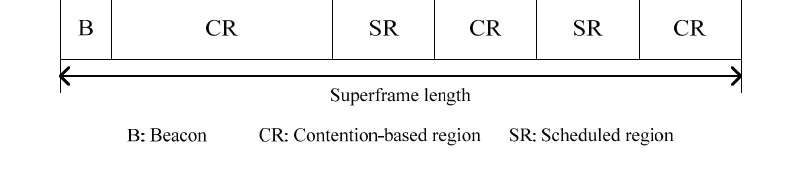
Figure 4. Superframe structure in AIIA.